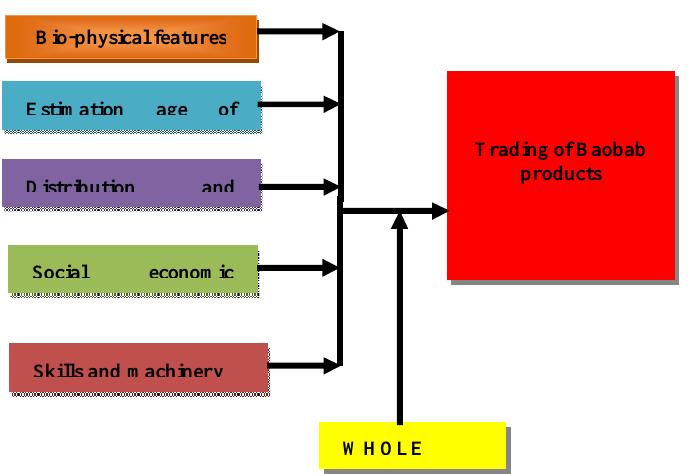
Figure 1: Conceptual